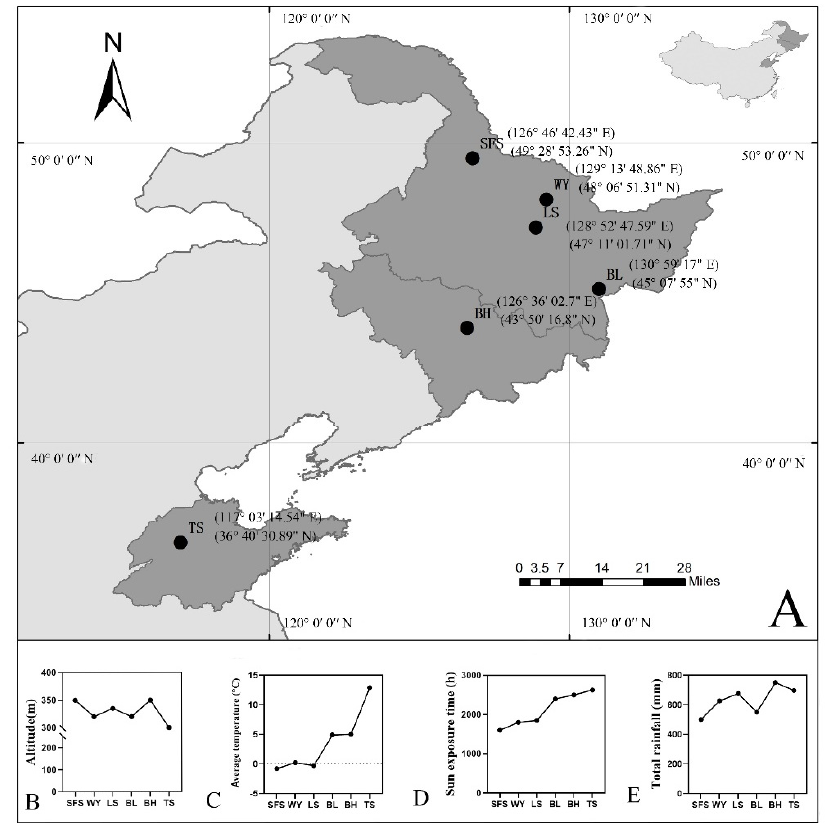
Figure 1. ( A ) distribution area of sampling points; ( B ) altitude (m) of sampling point; ( C ) average temperature ( ◦ C); ( D ) annual sunshine percentage (%); and ( E ) total rainfall (mm). Annual sunshine percentage means actual sunshine hours as a percentage of available sunshine hours over a one- year period.